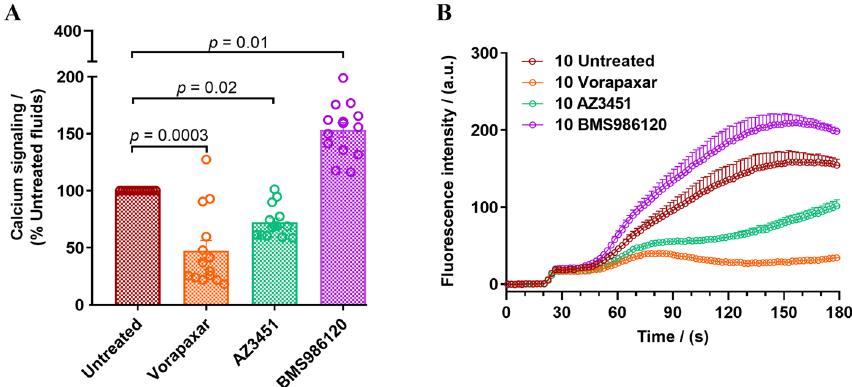
Figure 5. OA joint fluid activation of PAR mediated calcium signaling. Synovial fluids (10%) were added to HEK293 cells expressing PAR1, PAR2 and PAR4. Elevation in intracellular calcium levels were monitored in ( A ) untreated cells and cells pretreated with PAR antagonists, Vorapaxar, 1000 nM (PAR1 antagonist), AZ3451, 1000 nM (PAR2 antagonist) and BMS986120, 1000 nM (PAR4 antagonist). Scatter plots depict peak calcium signaling levels in individual experiments as a percentage of the response elicited by the synovial fluid samples in untreated cells. One-Way ANOVA Kruskal–Wallis test was utilized to assess differences between groups. p < 0.05 was considered statistically significant. ( B ) A representative calcium signaling trace obtained for PAR mediated calcium signaling triggered by one patient sample in the absence and presence of PAR1, PAR2, and PAR4 antagonists. The data represent the mean ± SEM of three independent experiments ( N = 3) performed in